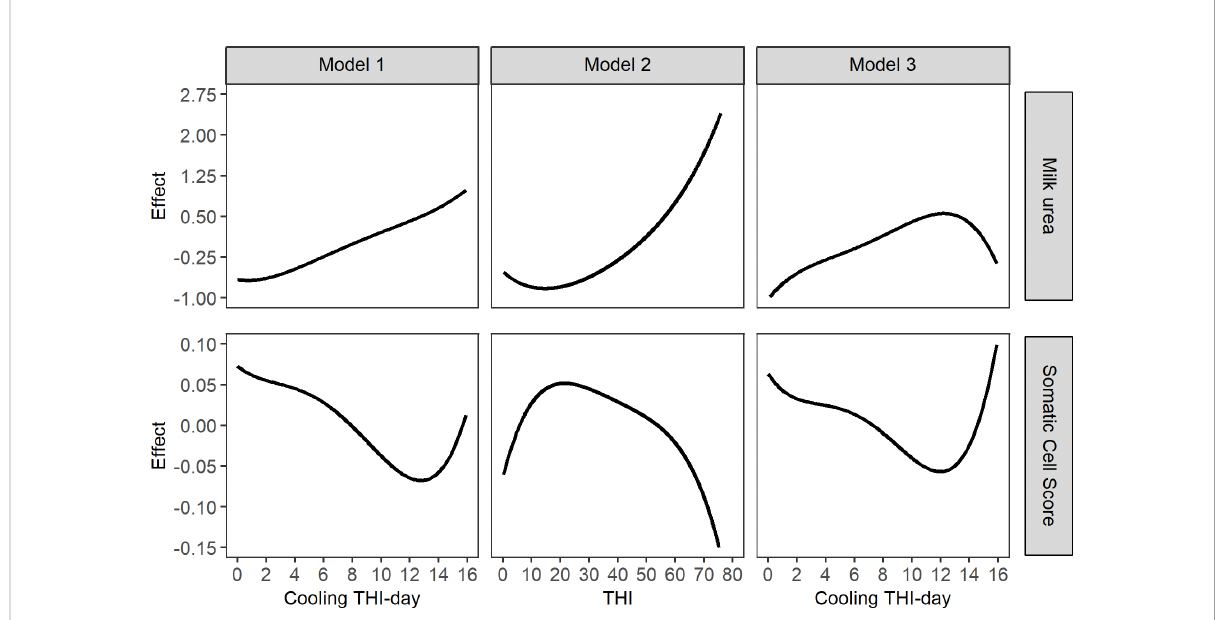
FIGURE 5 Reaction of milk urea (top) and somatic cell score (SCS, bottom) to THI and cooling THI-day full model (left; plot is for cooling THI-day), THI (middle), and cooling THI-day